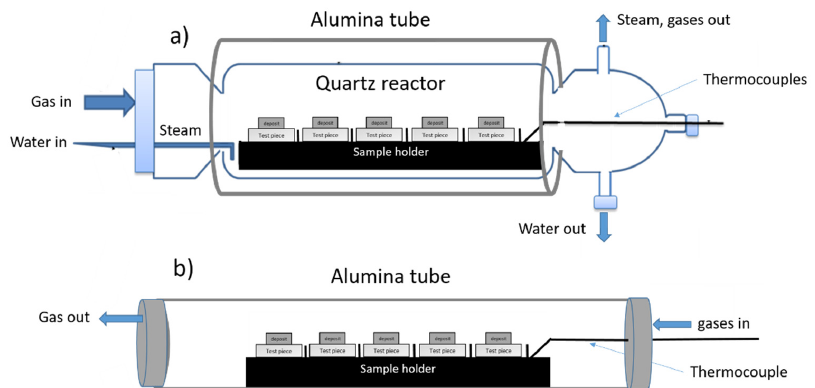
conditions. Figure 3. Quartz reactor and alumina tube used in experiments under ( a ) reducing and ( b ) oxidizing conditions.